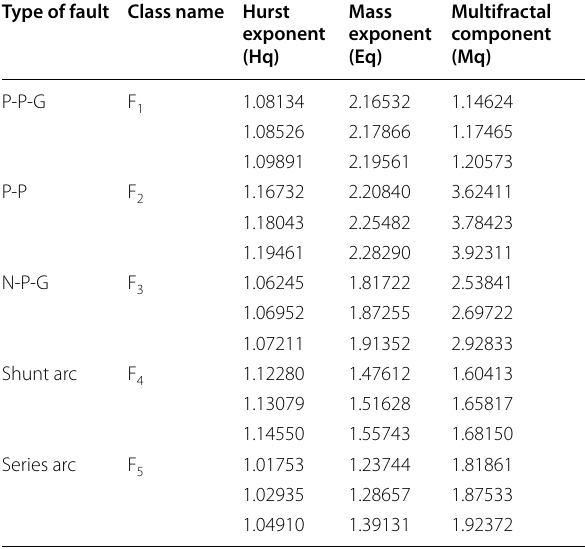
Table 7 Kurtosis index (KI) data for multifractal feature